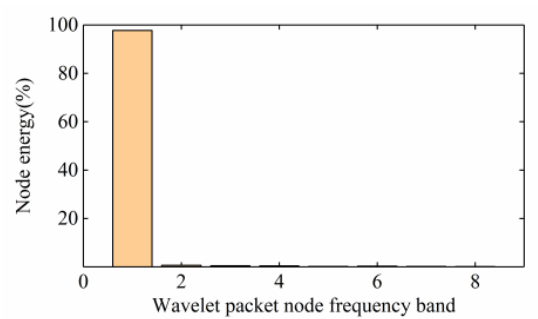
Figure 15. Energy distribution of the typhoon wavelet packet.